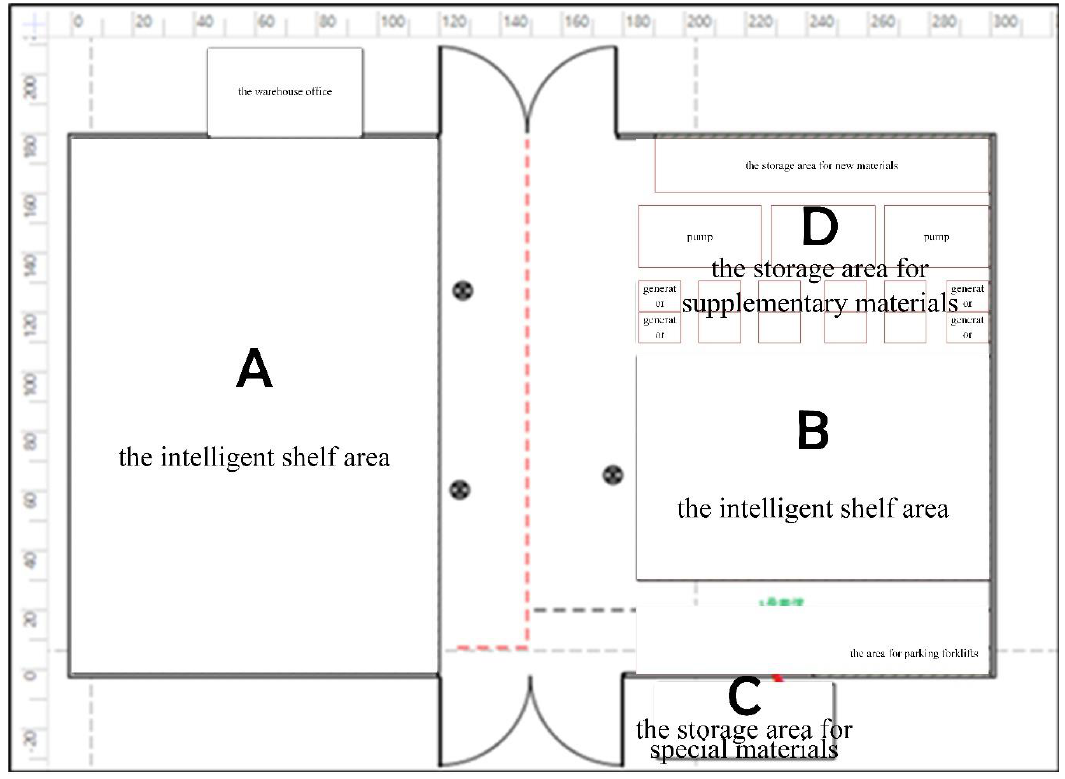
Figure 7. Plan layout.